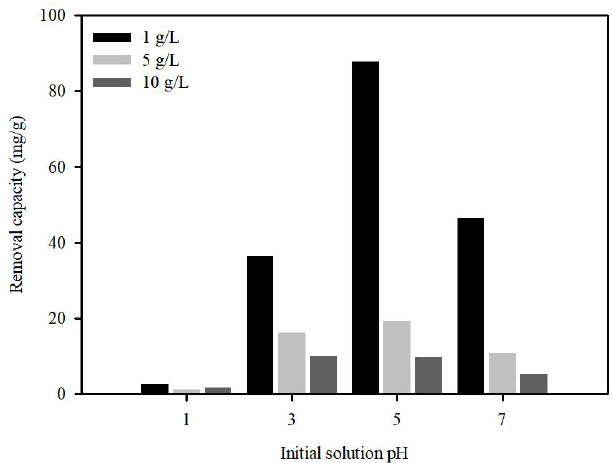
Figure 7. Adsorption of Pb( Ⅱ ) on S.P@Ca-SA as affected by aqueous pH.